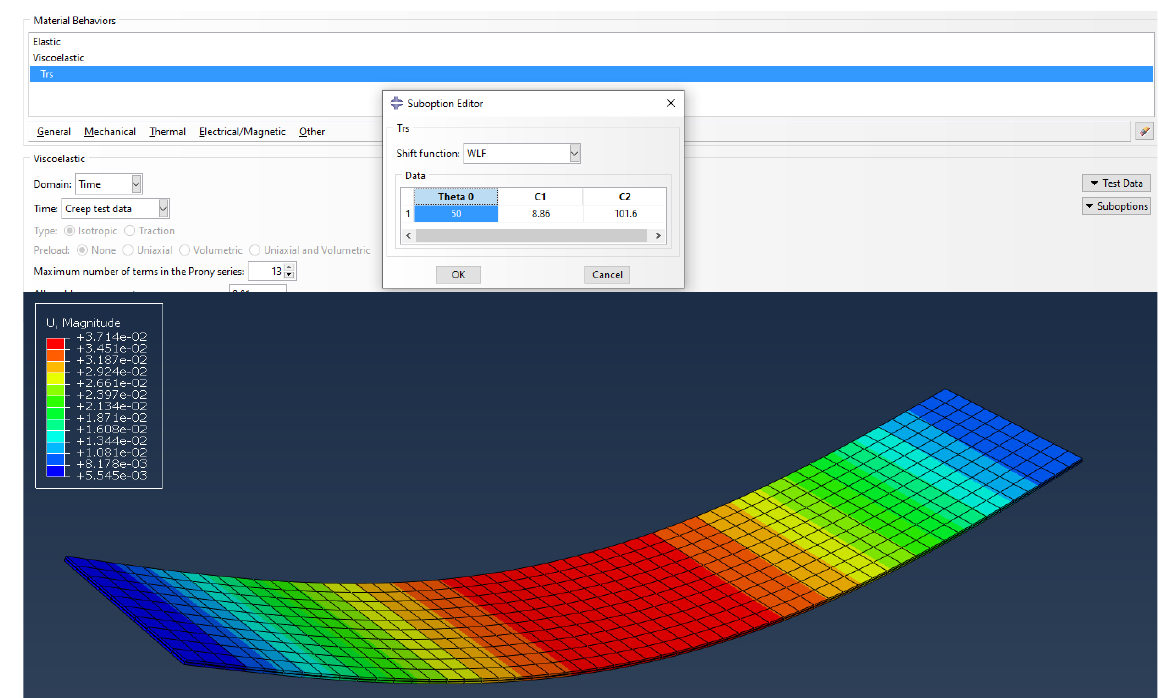
Figure 18. Abaqus SIMULIA FEM analysis of laminated glass.